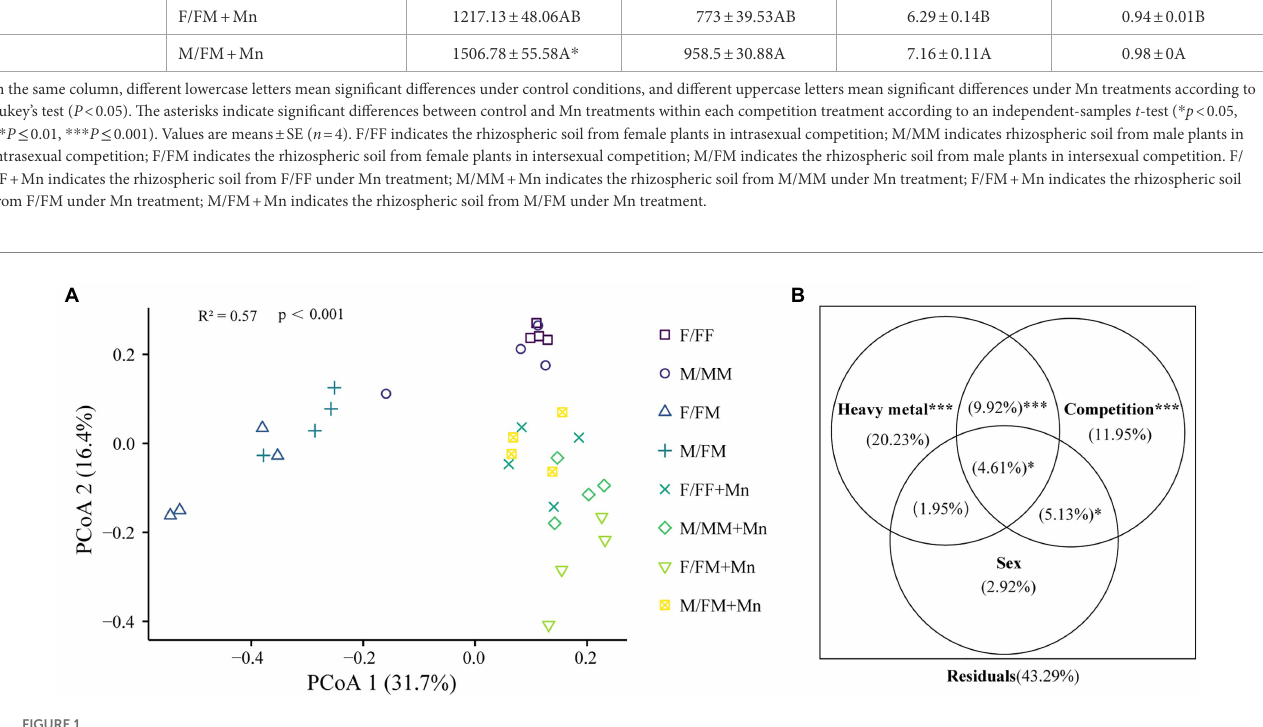
FIGURE 1 Principal coordinates analysis (PCoA) (A) and PERMANOVA results (B) based on Bray-Curtis distance metrics. Different colors or shapes represent different sample groups under different sexual competition patterns and Mn treatment; treatment codes are the same as in Table 2. Heavy metal: control, Mn treatment; Competition: intrasexual competition, intersexual competition; Sex: F, M. *0.01 < p ≤ 0.05; **0.001 < p ≤ 0.01; *** p ≤ 0.001.